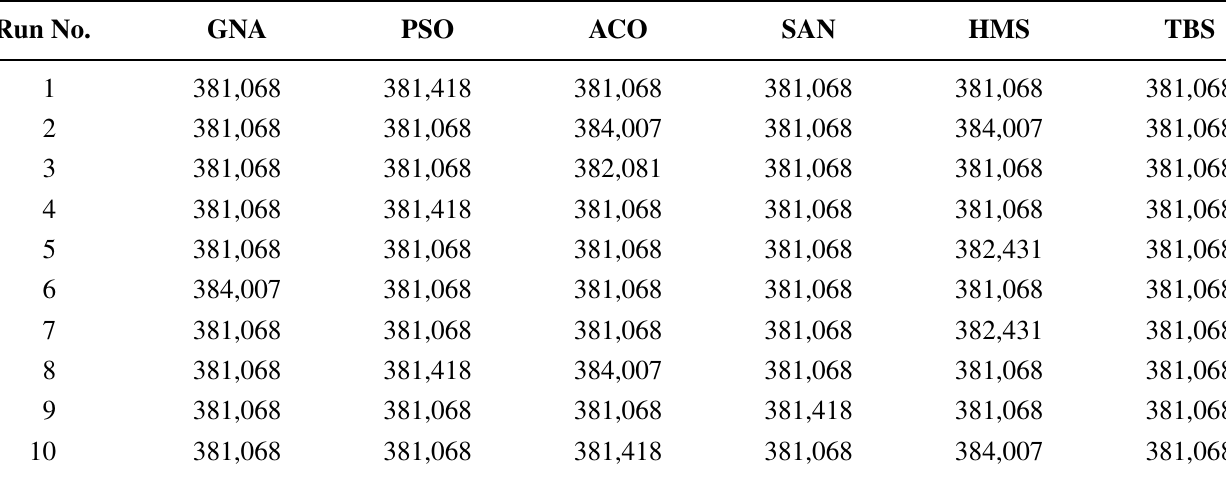
Table 6. Objective function values, in (EUR), for each metaheuristic method. Run No. GNA PSO ACO SAN HMS